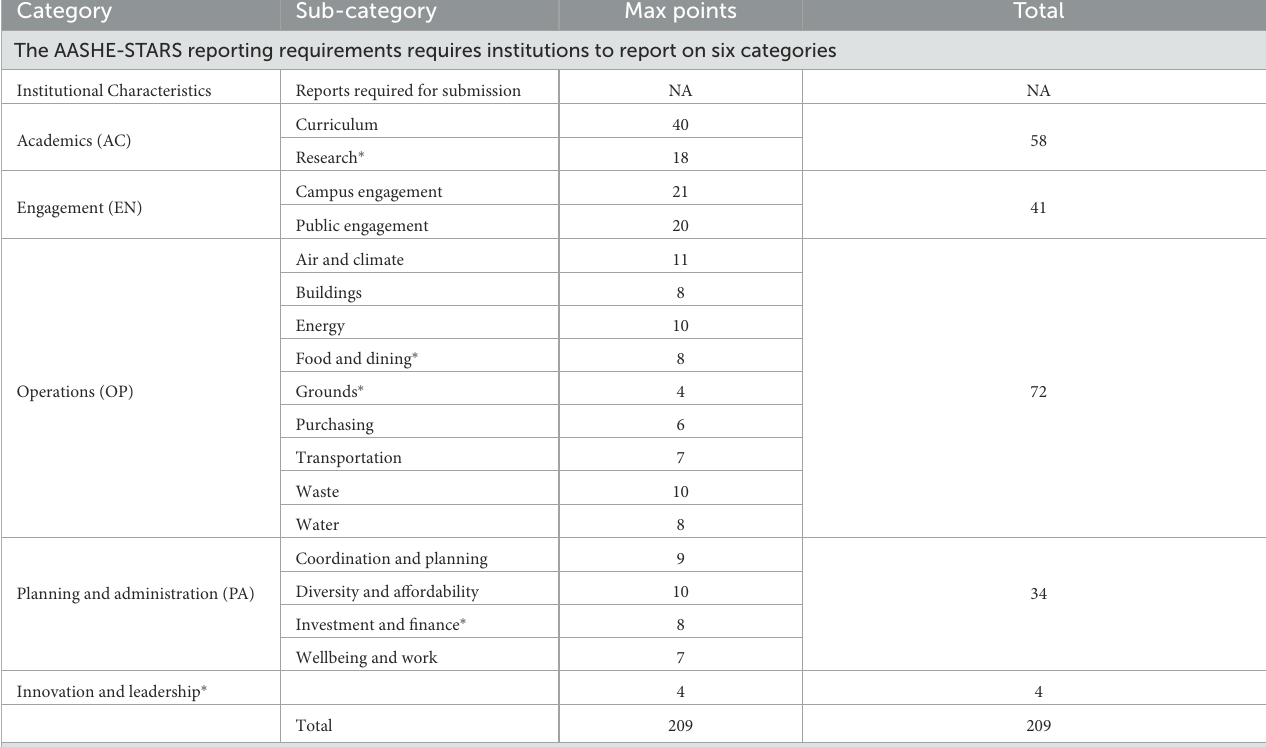
TABLE 1 Summary of AASHE-STARS reporting requirements and the results from applying the computational (TF-IFD) technique to 5,773 TU Dublin module/course descriptors. Category Sub-category Max points